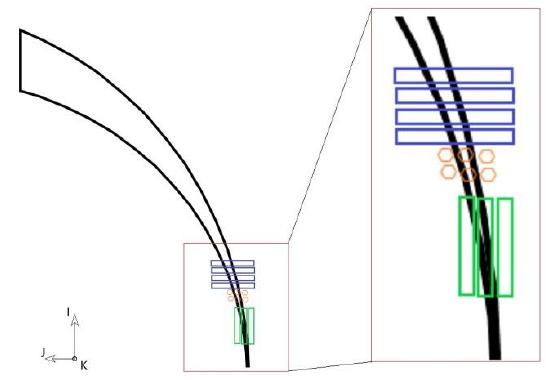
Figure 18. Areas cut in each cycle with green grains along the cut (I-direction), blue grains perpendicular to the cut (J-direction), and orange grains perpendicular to the figure plane (K-direction). This figure represents the top side of the workpiece shown in Figure 17.